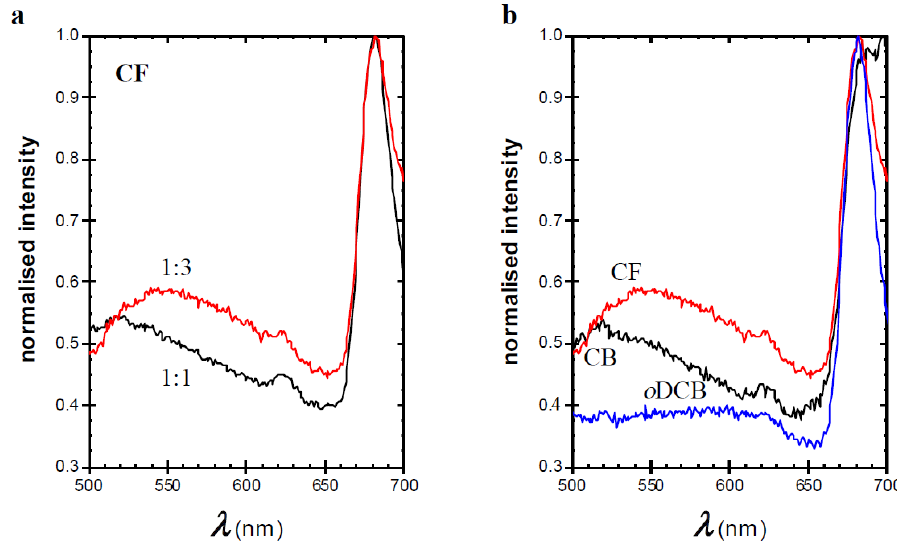
Figure 3. Fluorescence emission spectra of thin films measured with excitation wavelength (λ ex ) = 380 nm of ( a ) 1:1 (black) and 1:3 (red) TQ1:PC 70 BM spin-coated from CF ( b ) 1:3 TQ1:PC 70 BM spin-coated from CF (red), CB (black), and o DCB (blue).